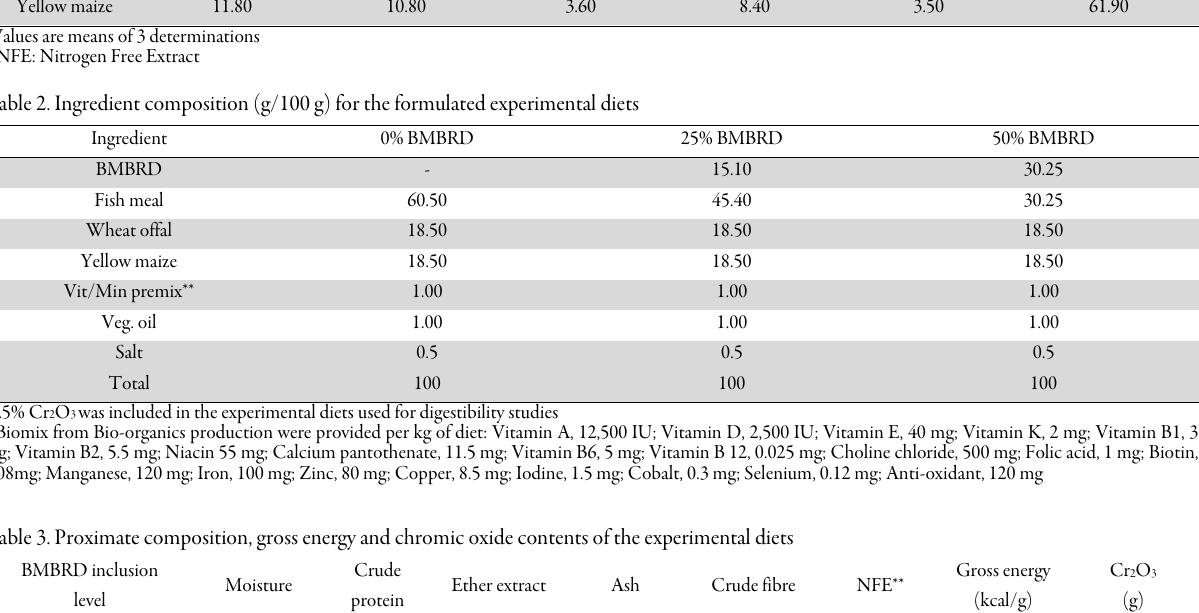
Table 1. Proximate composition* of the feedstuffs used to formulate the experimental diets Ingredient Moisture content Crude protein Fish meal Wheat offal Yellow maize